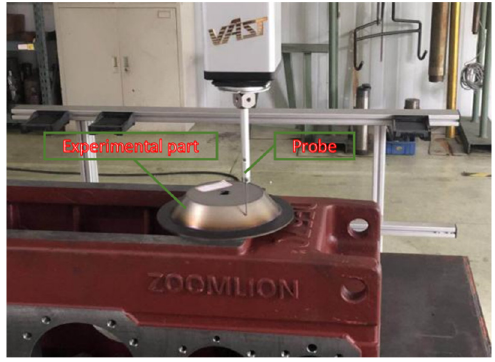
Figure 13. Coordinate measurement.